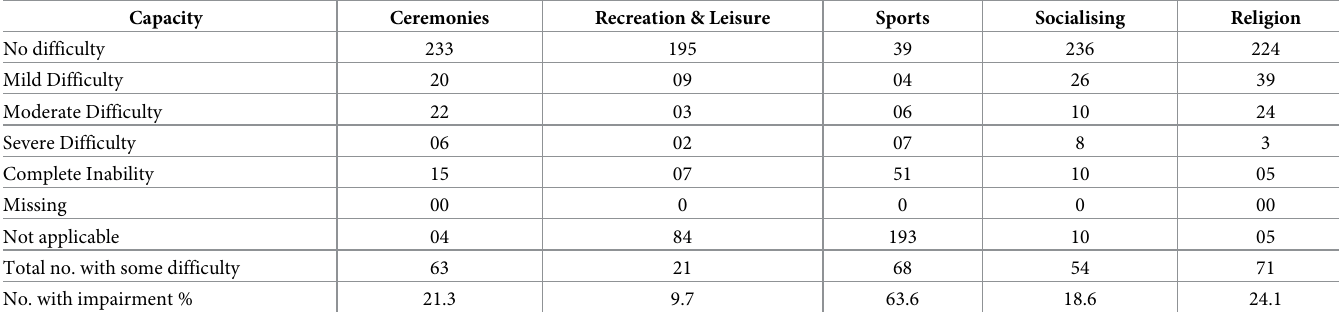
Table 10. Impairments in community, social and civic